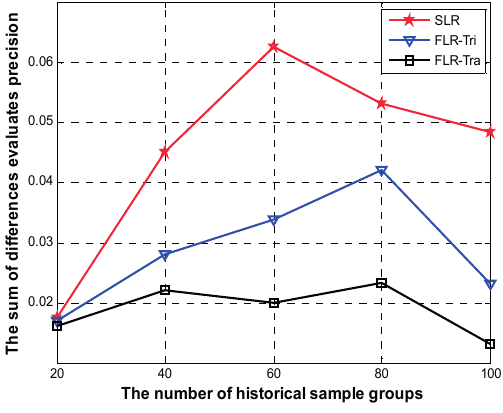
Figure 7. The sum of differences of evaluation precision R .